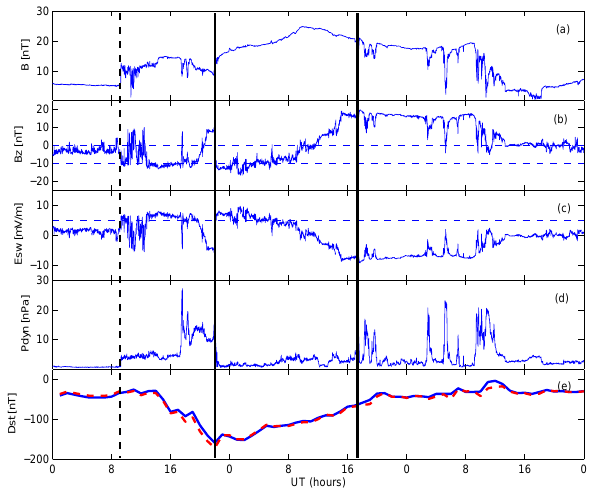
Fig. 10. Solar wind parameters and geomagnetic indices for a 3-day interval from 6–8 November 2000 measured by ACE. The figures from top to bottom are the same as in Fig. 9. The dashed line indi- cates the shock and two solid lines indicate the interval of an